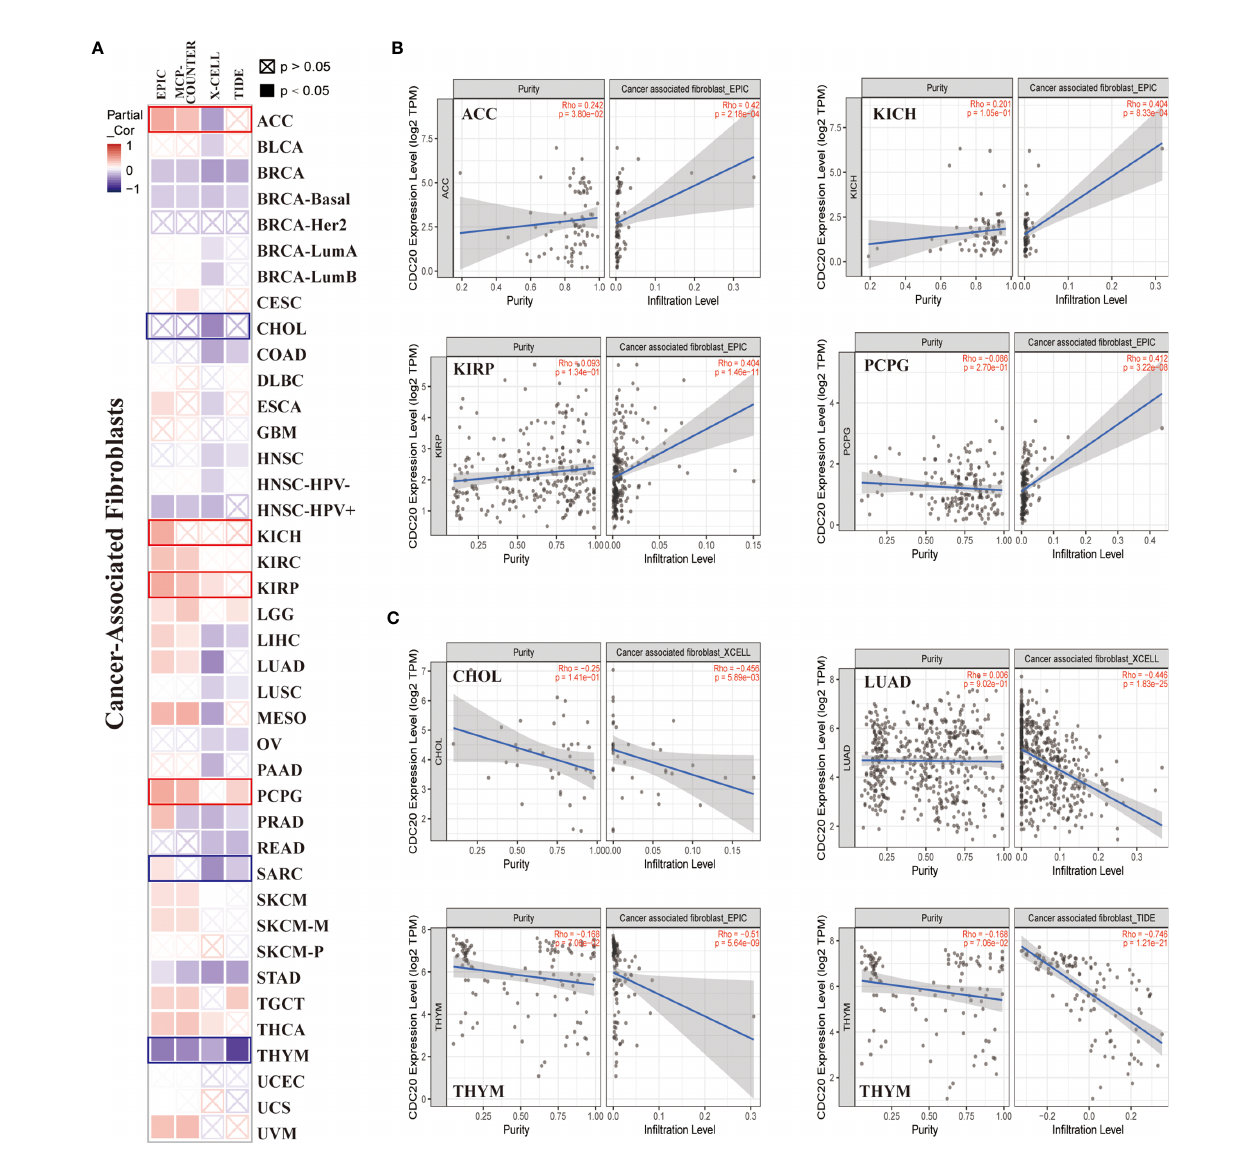
FIGURE 4 | The correlation between CDC20 expression and immune in fi ltration of cancer-associated fi broblasts. (A) The potential correlation between the expression level of the CDC20 gene and the in fi ltration level of cancer-associated fi broblasts across 33 subtypes of cancer in TCGA using different algorithms by TIMER2.0, visualized in a heatmap by Spearmans ’ Rho value. (B, C) The expression levels of the CDC20 gene are positively or negatively correlated with the in fi ltration level of cancer-associated fi broblasts by the cut-off value of 0.4 of Spearmans ’ Rho Value in selected cancer